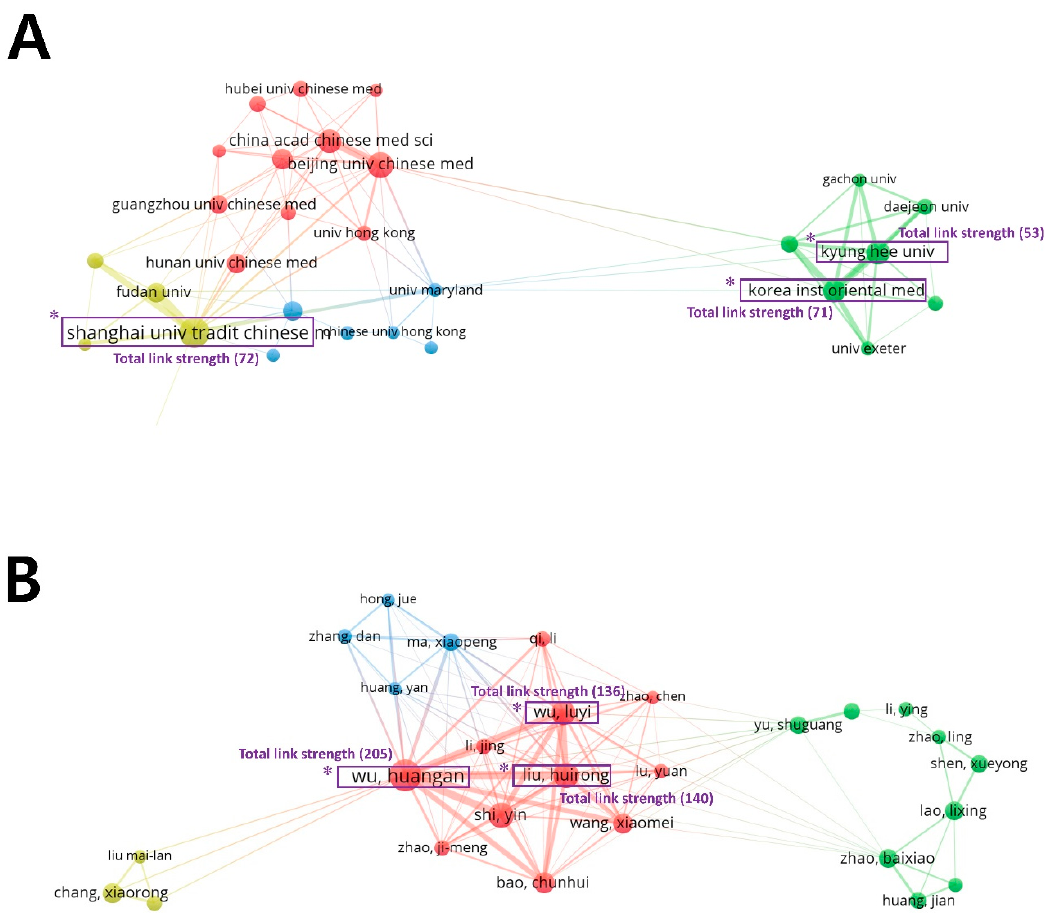
Figure 4. Network map of organizations and authors. ( A ) Distribution of 29 organizations that had at least 10 publications, according to the number of documents. These were classified into four clusters. ( B ) Distribution of 27 authors who had at least eight publications according to the number of documents. These were classified into four clusters. * Represents the top three organizations and the authors with the highest total link strengths.